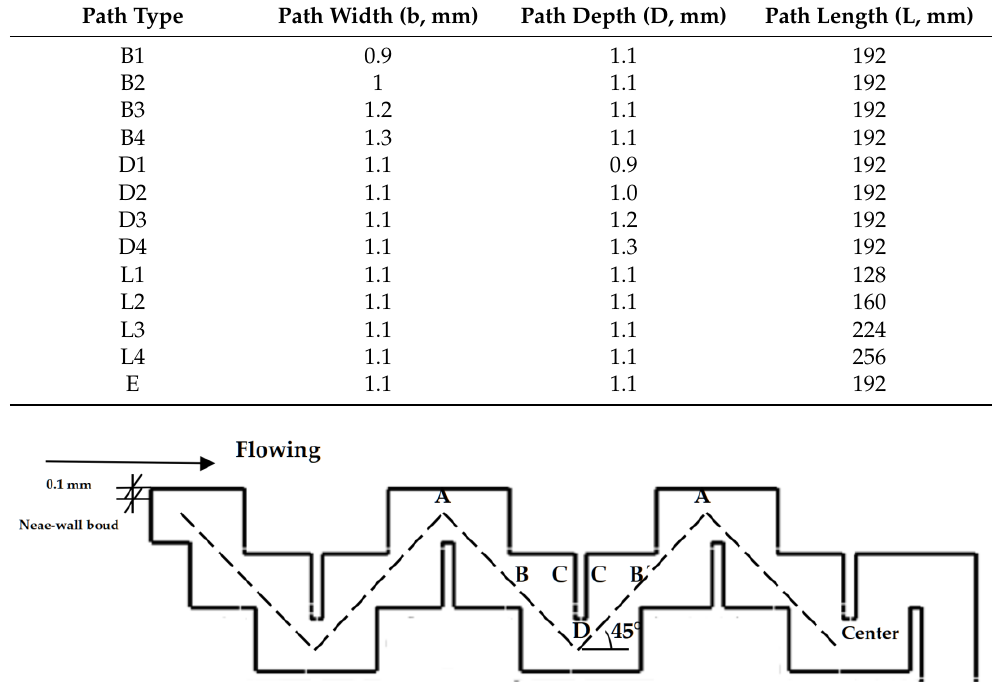
Figure 5. Schematic diagram of the cross-section of the flow path unit section (Z = 0.5D).